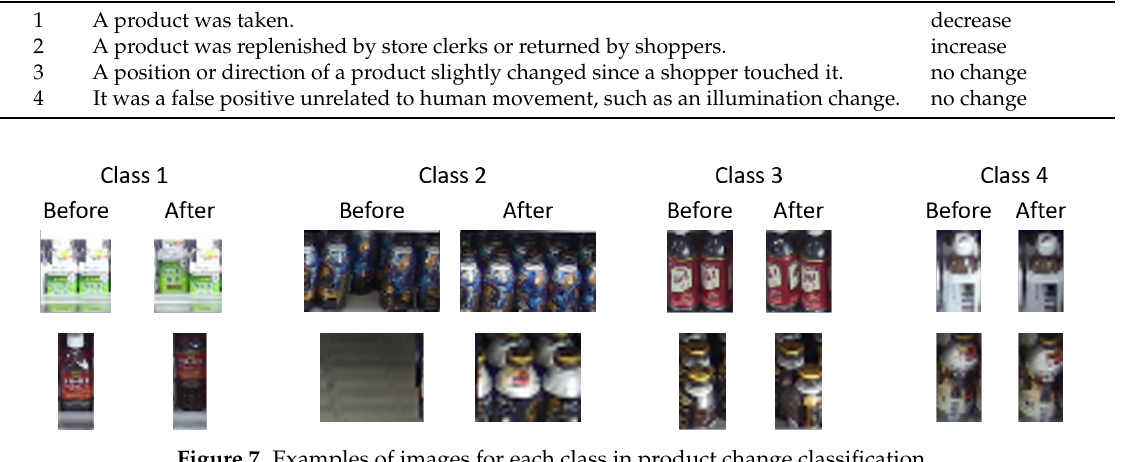
Figure 7. Examples of images for each class in product change